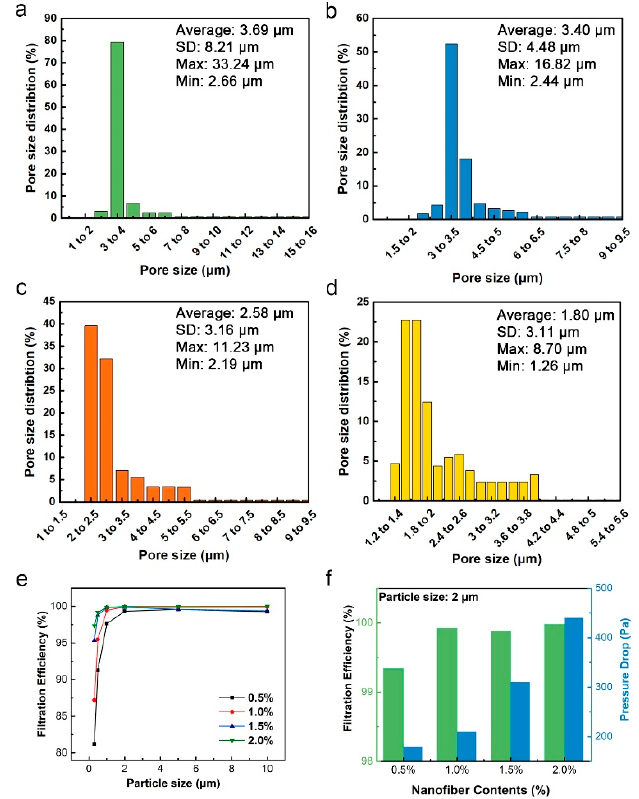
Figure 9. The pore sizes and pore sizes distribution of PI/PTFE–PAI NAs with different fiber contents of ( a ) 0.5%, ( b ) 1.0%, ( c ) 1.5%, ( d ) 2.0%, as PAA: PTFE–PAI@PEO was 5:5 and the sintering temperature was 400 °C; ( e ) Filtration efficiency for PM of different size; ( f ) the filtration efficiency and pressure drop for PM 2.0 . Table 2. The filtration performance of PI/PTFE–PAI NAs of different fiber content as the ratio of PAA/PTFE was 5:5 and the sintering temperature was 400 °C. Filtration